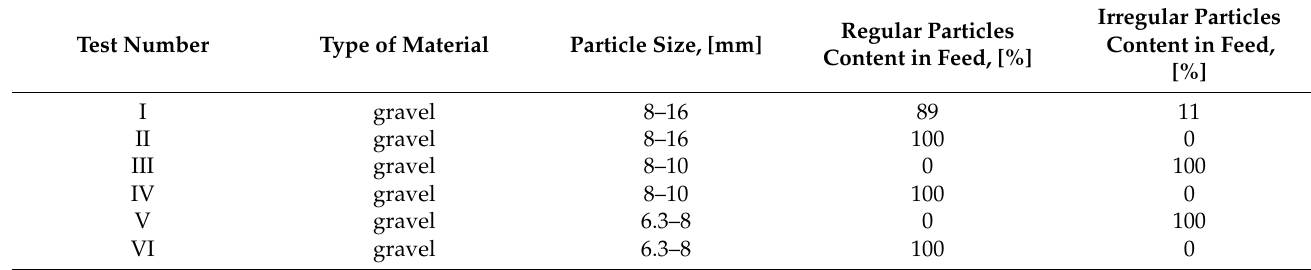
Table 3. Summary characteristics of individual tests.